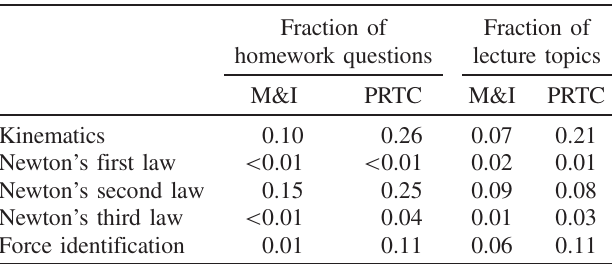
TABLE IV. Estimated fractions of homework questions and lecture devoted to the subtopics tested in the FCI. Reproduced from Caballero et al. [16] with